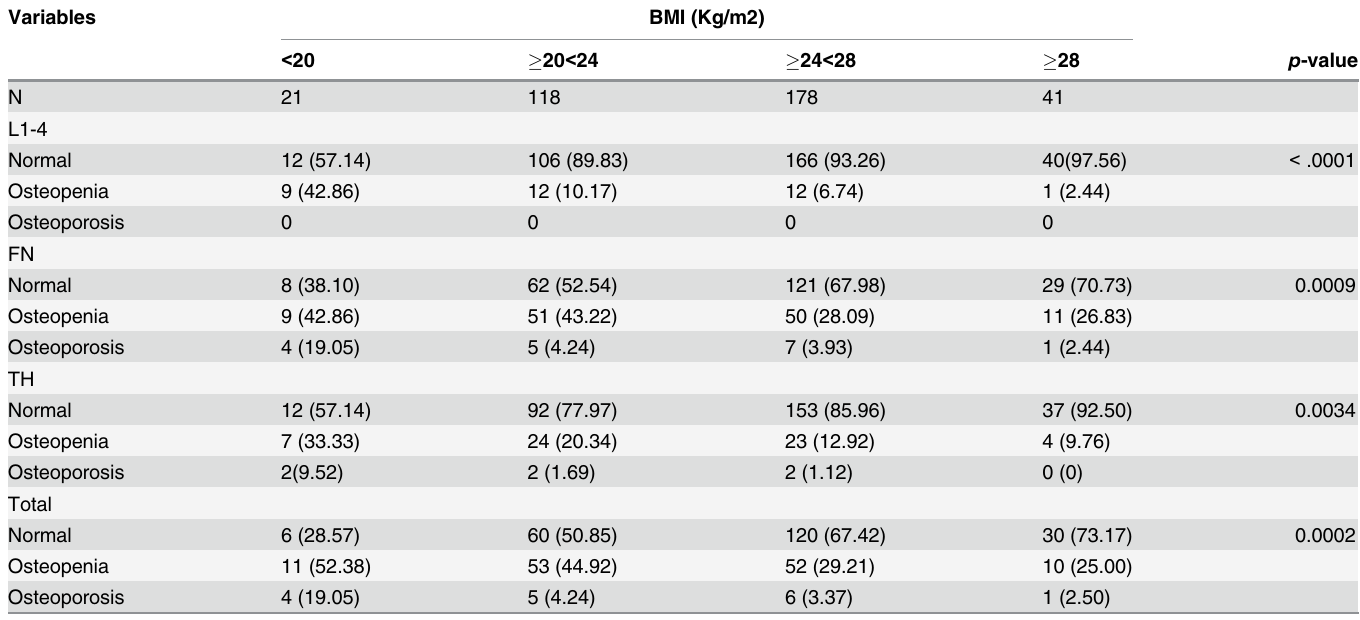
Table 3. The detection rate of osteoporosis or osteopenia by different BMI